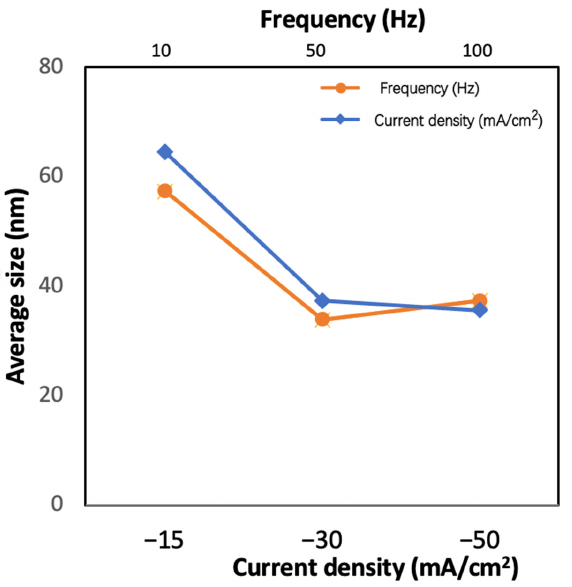
Figure 4. The relation between current density/frequency and an average particle size.